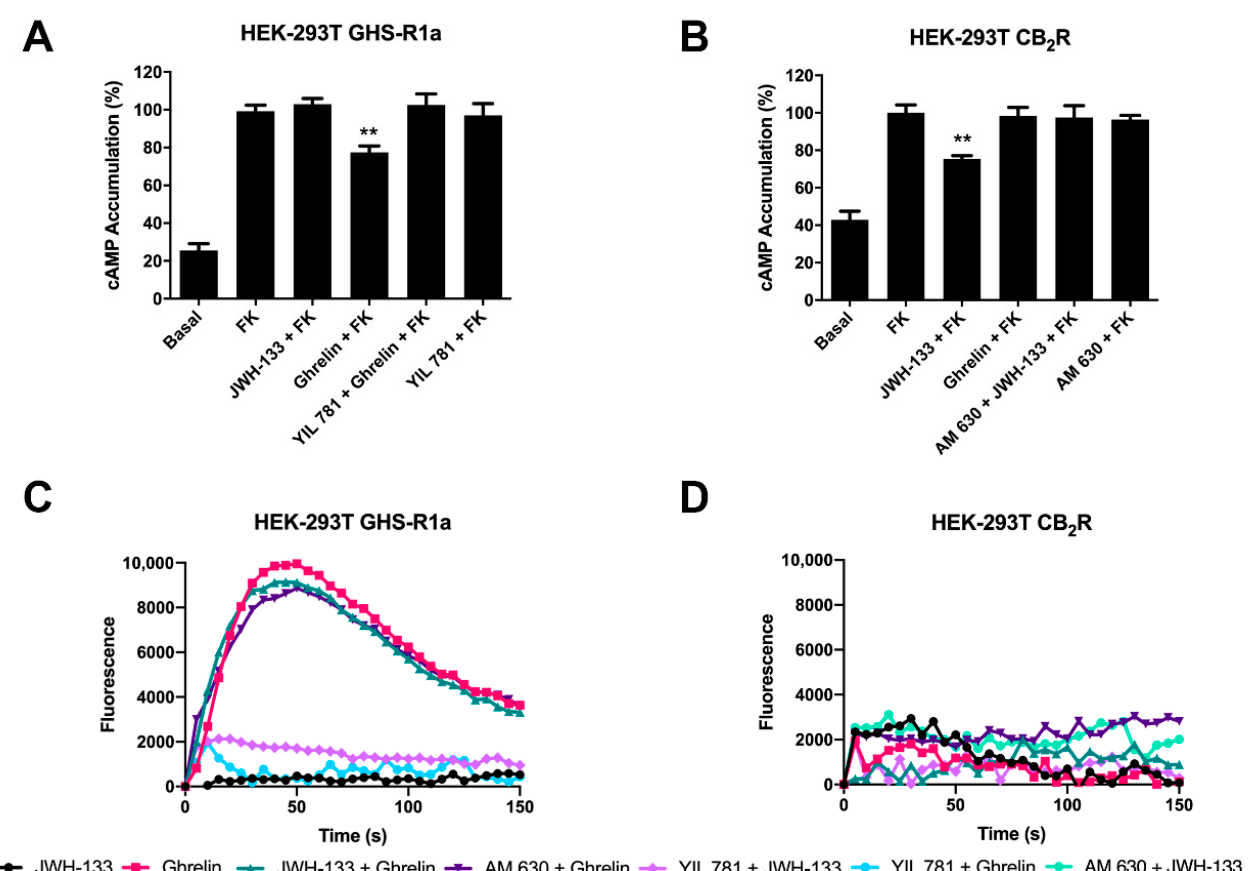
Figure 2. Functional characterization of GHS1a and CB 2 receptors expressed in HEK-293T cells. ( A , B ) HEK-293T cells transfected with plasmids encoding for either GHSR1a (1.5 µ g) ( A ) or CB 2 R (1 µ g) ( B ) were pre-treated with selective antagonists, 1 µ M YIL 781-GHSR1a- or 1 µ M AM 630-CB 2 R, and subsequently treated with the selective agonists, 200 nM ghrelin -GHSR1a- or 200 nM JWH-133 -CB 2 R-. cAMP levels after 0.5 µ M forskolin stimulation were detected by the Lance Ultra cAMP kit and the results were expressed in % respect to levels obtained upon forskolin stimulation. The values are the mean ± SEM of 10 different experiments performed in triplicates. One-way ANOVA followed by Dunnett’s multiple comparison post-hoc test were used for statistical analysis. ** p < 0.01, versus forskolin treatment. ( C , D ) HEK-293T cells expressing an engineered calcium sensor, GCaMP6 and GHSR1a ( C ) or CB 2 R ( D ) were pre-treated with selective antagonists for 10 min followed by agonist stimulation. Representative traces of intracellular Ca 2+ responses over time are shown (6 independent